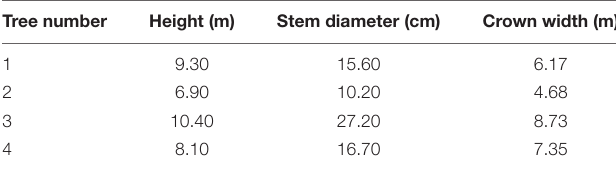
TABLE 1 | Basic parameters of sample tree. Tree